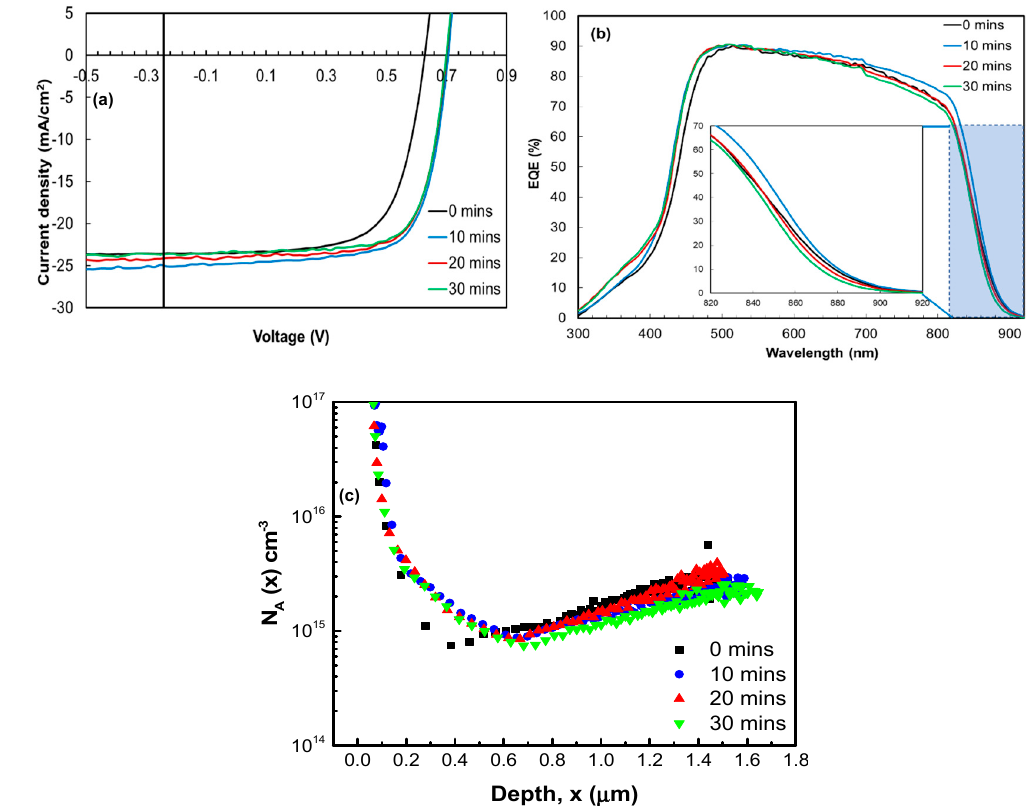
Figure 4. ( a ) Illuminated J-V curves ( b ) EQE spectra and ( c ) acceptor concentration profiles of ZnTe:As back contacted devices annealed at 420 °C for different times.